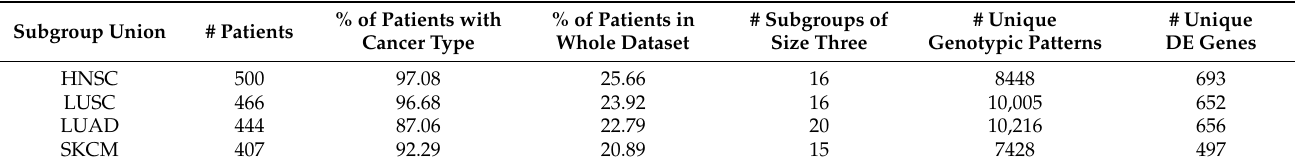
Table 1. Subgroup summary for selected subgroup